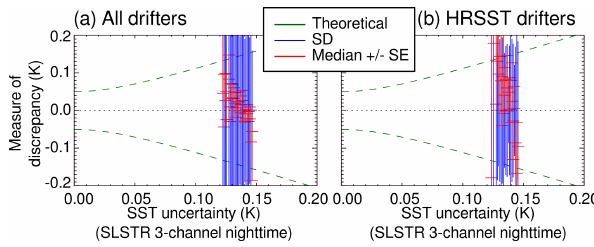
Figure 5. SLSTR SST uncertainty validation plot for (a) all drifters and (b) a subset of HRSST-1 and HRSST-2 drifters, with uncer- tainty bins of 0.001K. An uncertainty of 0.05K is assumed for the drifter